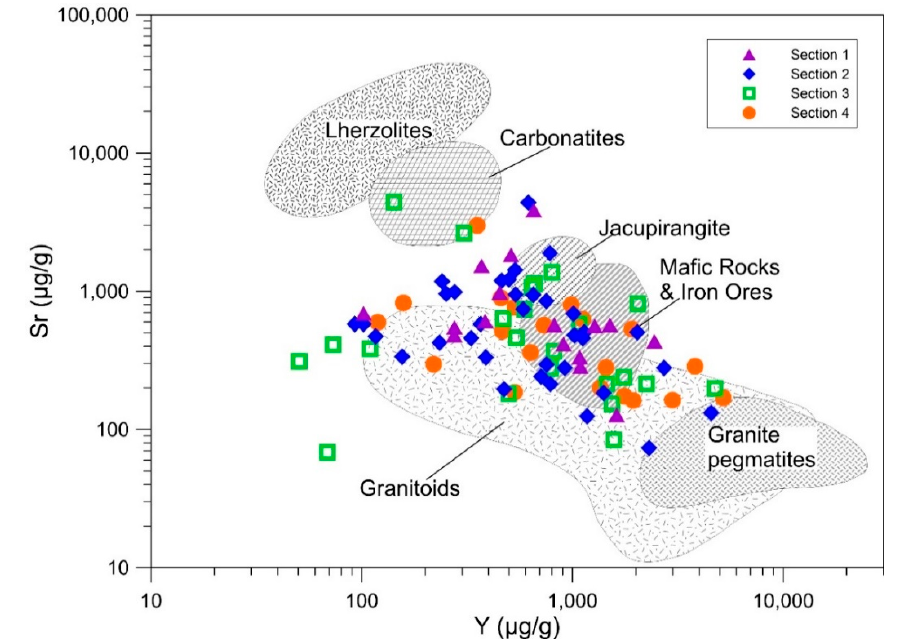
Figure 6. Sr vs. Y genetic plot proposed by Reference [20] showing the analyzed apatite compositions in the four sections of Core S3 from the SOT.